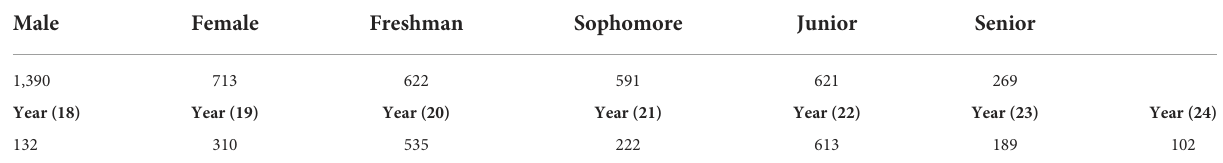
TABLE 2 The distribution of recruited participants in the experiment.